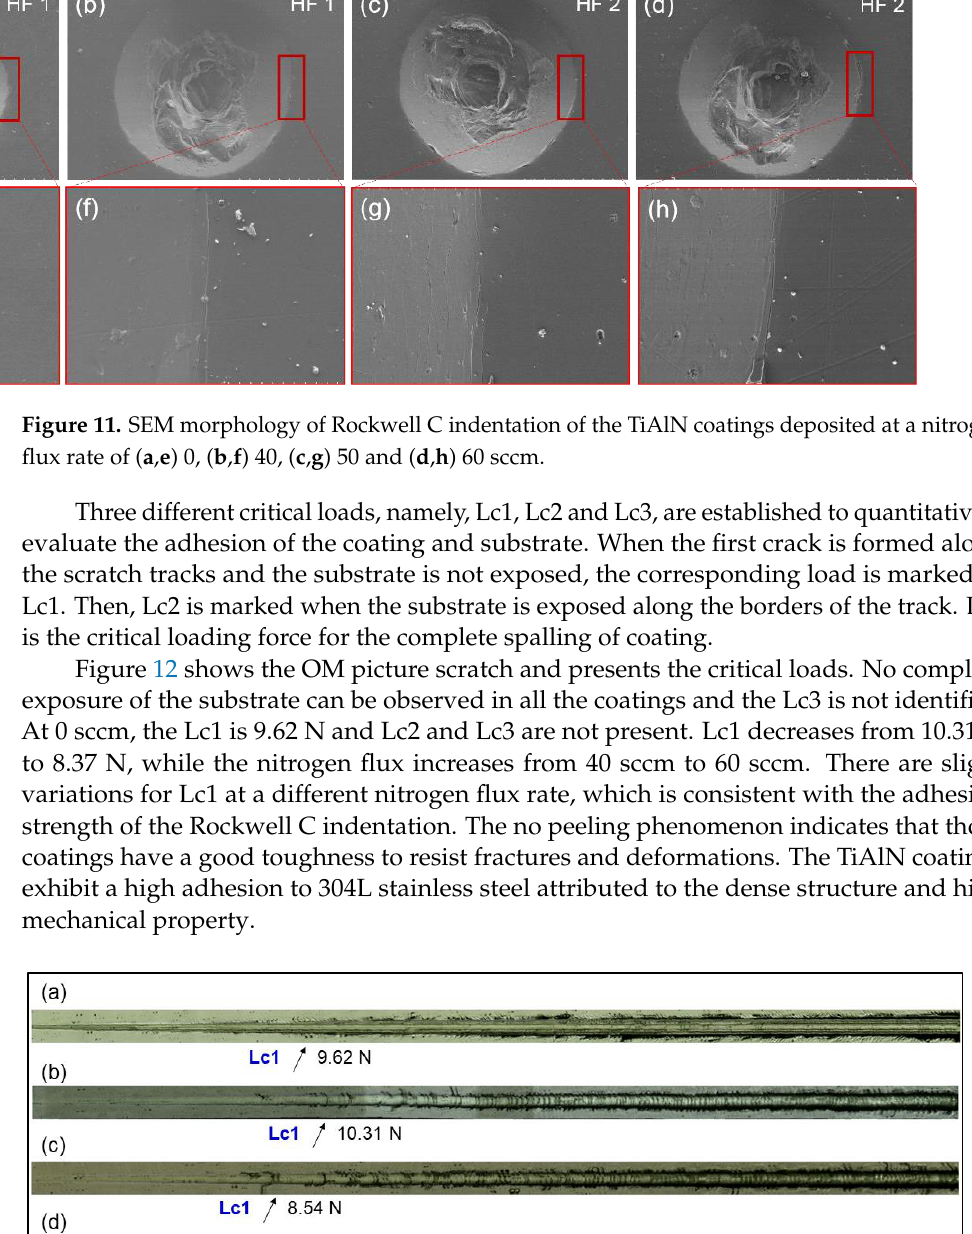
Figure 12. OM pictures of the scratch test for TiAlN coatings deposited under the nitrogen flow rates of 0 sccm ( a ), 40 sccm ( b ), 50 sccm ( c ) and 60 sccm ( d ).